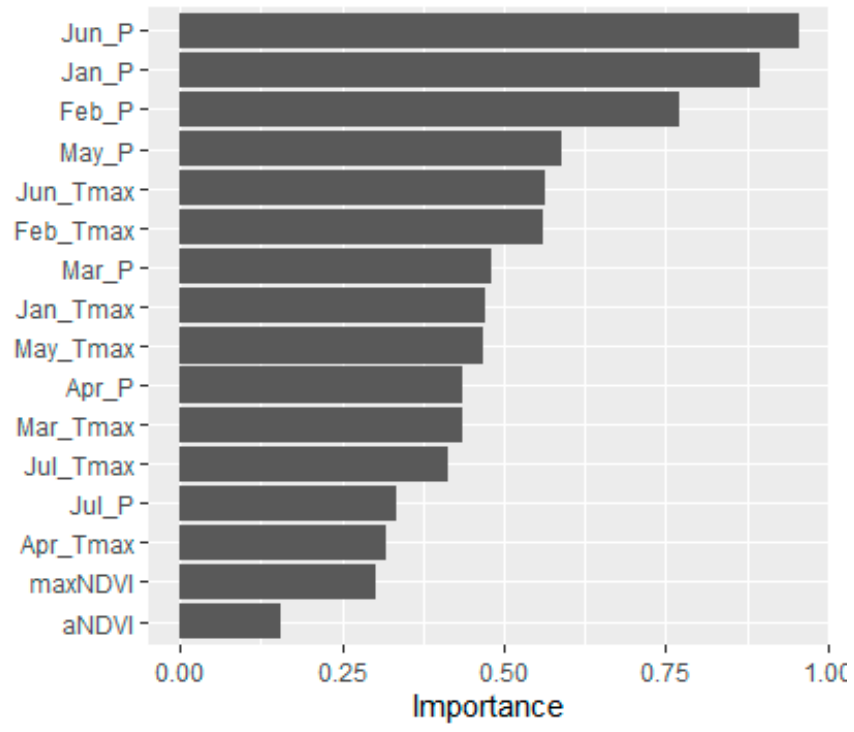
Figure 6. Importance scores of predictor variables for Model 3. In Model 3, winter wheat yield was modelled as a function of monthly precipitation values and maximum temperature values during the winter wheat growing season from January to July, aNDVI and maxNDVI. P: precipitation; Tmax: maximum temperature; months from January to July are indicated by the first three letters of each month.